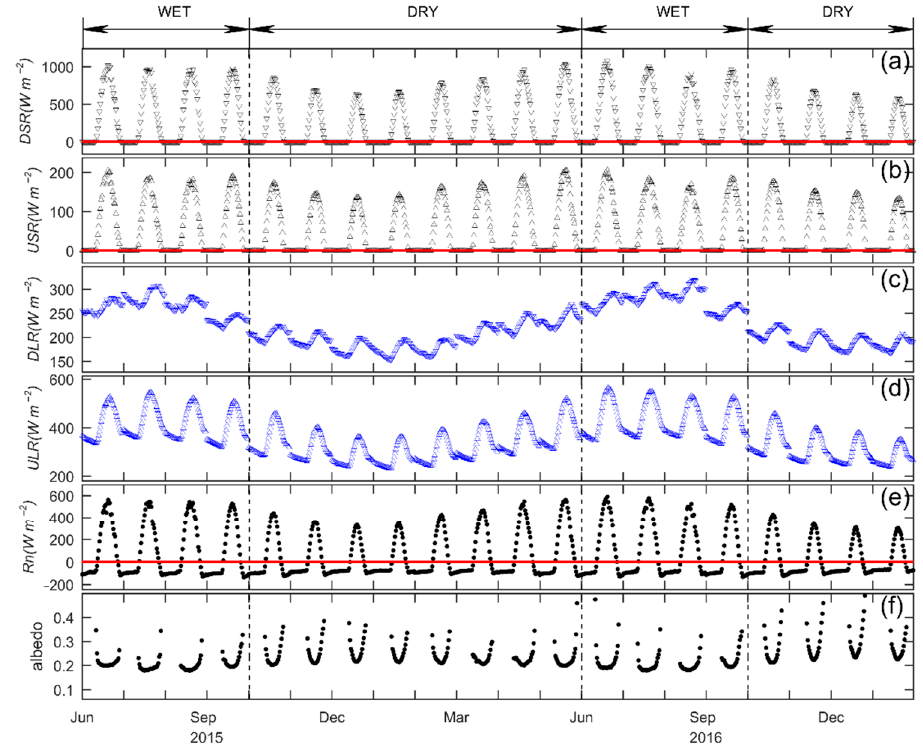
Figure 3. The monthly averaged diurnal variations of ( a ) downward shortwave radiation ( DSR in W m − 2 ), ( b ) upward shortwave radiation ( USR in W m − 2 ), ( c ) downward longwave radiation ( DLR in W m − 2 ), ( d ) upward longwave radiation ( ULR in W m − 2 ), ( e ) net radiation ( Rn in W m − 2 ) and ( f )